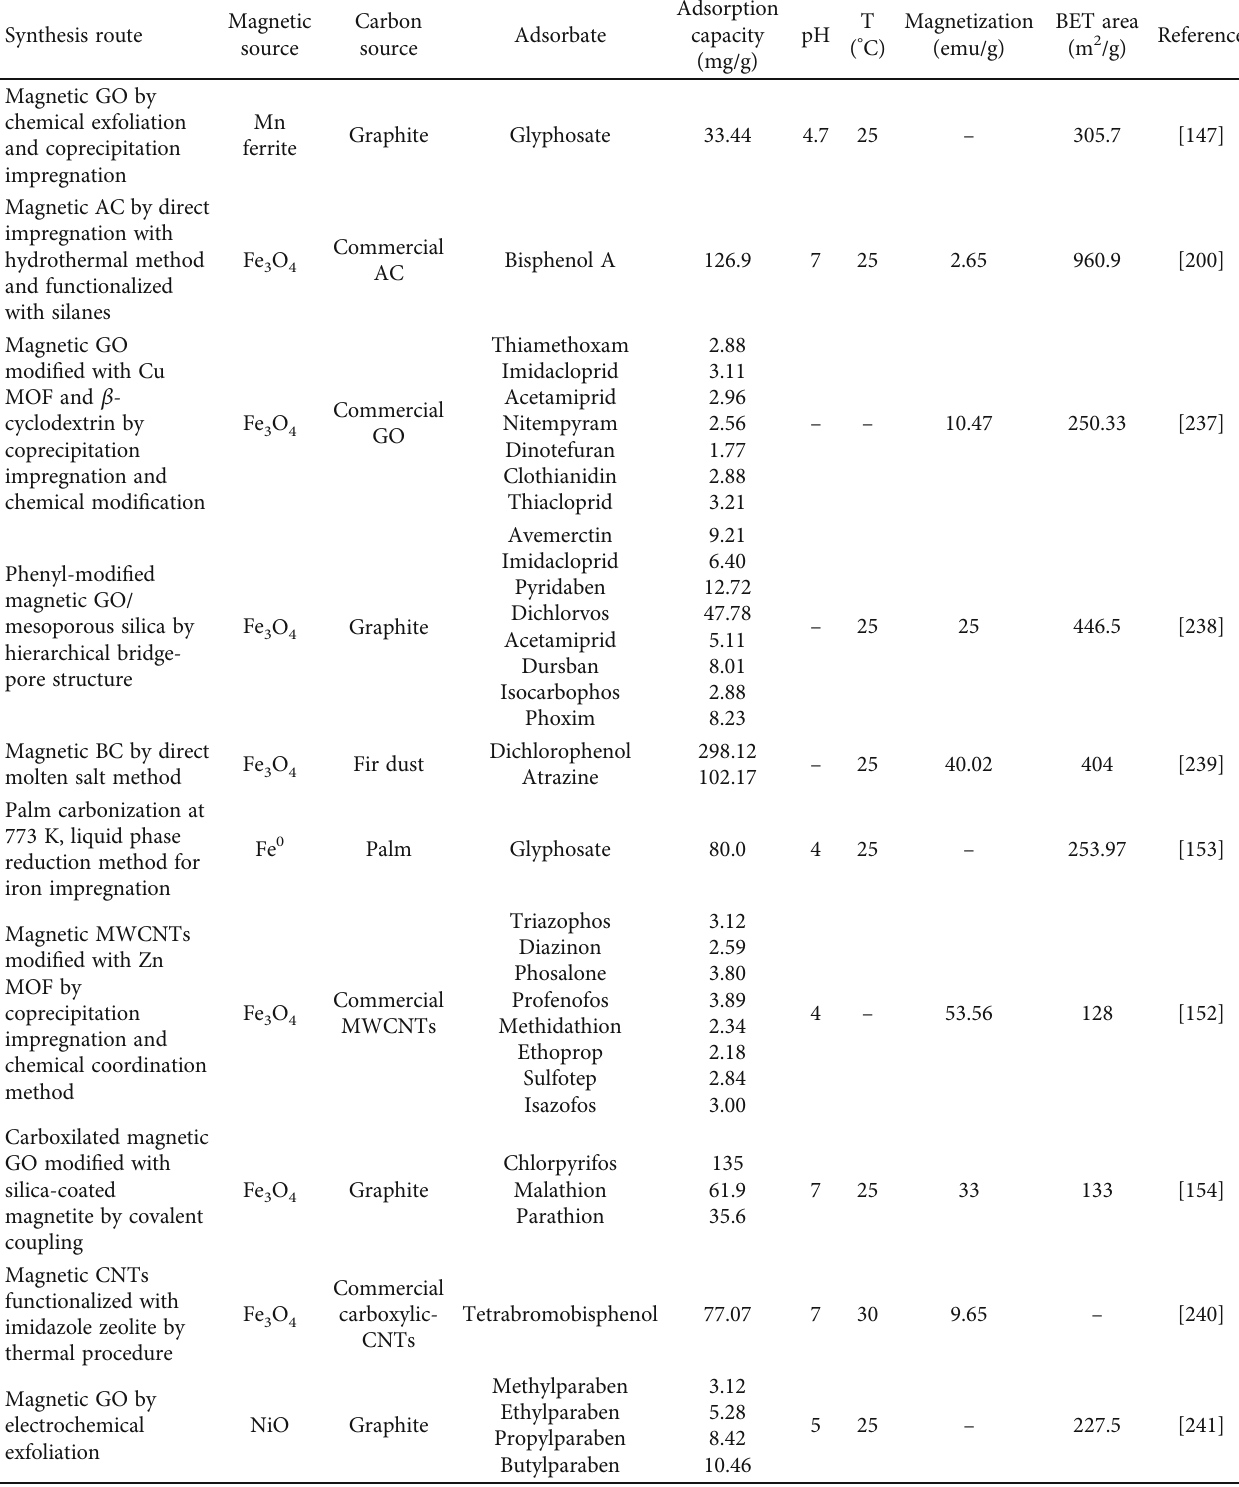
Table 4: Removal of pesticides and other pest controllers from aqueous solution using magnetic carbon-based adsorbents: preparation, removal operating conditions, and adsorption